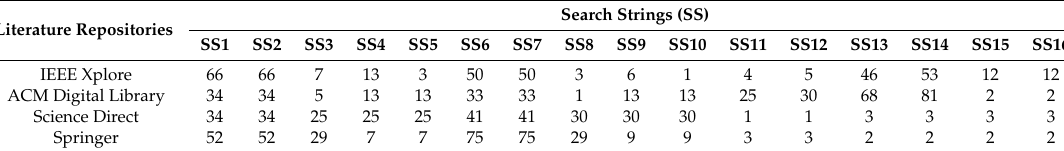
Table 2. Number of primary studies for each literature repository and search string.